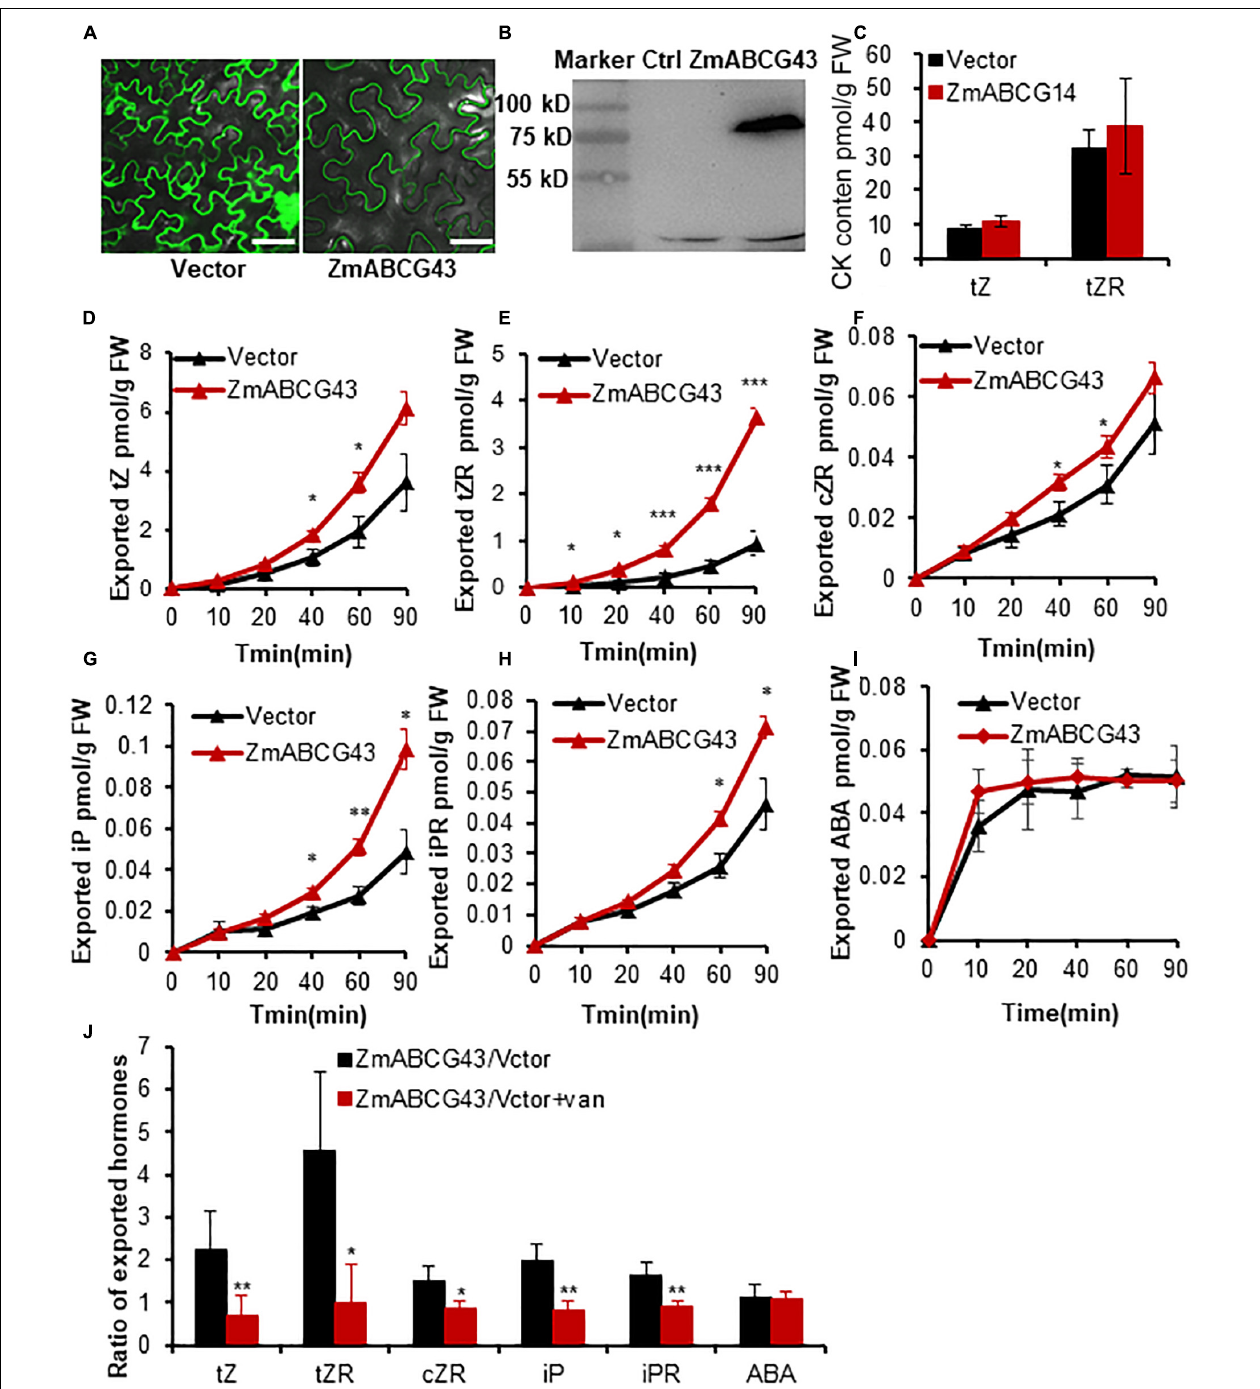
FIGURE 5 | Characterization of ZmABCG43 as a transporter for cytokinins using the TSAL method. (A) Transient expression and sublocalization of free GFP and fusion protein GFP-ZmABCG43 in tobacco leaves. Bar = 50 µ m. (B) Immunoblot analysis of GFP-ZmABCG43 fusion protein expression. M, marker; ZG43, total protein from tobacco leaves with transient expression of 35S:GFP-ZmABCG43 ; Ctrl, control, total protein from non-transgenic tobacco leaves. (C) Quantification of tZ and tZR in tobacco leaves expressing GFP and GFP- Zm ABCG43 before the uptake assay. (D–I) Quantification of the exported cytokinins including tZ, tZR, cZR, cZ, iP, and iPR from tobacco leaves transformed with GFP-ZmABCG43 or GFP at the time points of 0, 10, 20, 40, 60, and 90 min. (J) The ratios of efflux-transported cytokinins from tobacco leaves expressing GFP-ZmABCG14 and free GFP in the presence or absence of 1 mM of sodium vanadate at 60 min. Data are means ± SE ( n = 4). *, **, and *** indicate P -values of P < 0.05, P < 0.01, and P < 0.001, respectively, from Student’s t -test. ZG43, ZmABCG43.